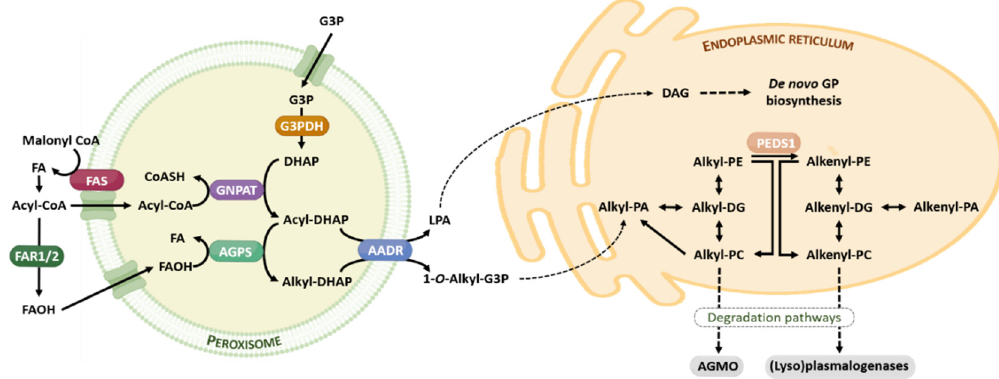
Figure 2. Ether lipid metabolism. The ether lipid biosynthesis process initiates in peroxisomes and is subsequently completed in the endoplasmic reticulum. Briefly, the early steps of ether lipid biosynthesis in the peroxisomes are based on substrates derived from fatty acid metabolism (AcylCoA) and glycolysis (DHAP), and the rate-limiting step is the provision of FAOH. The completion of GP biosynthesis occurs in the endoplasmic reticulum using DAG and Alkyl-PA as precursor molecules. The catabolism of ether lipids proceeds by their lyso-forms for alkyl lipids, and is catalyzed by AGMO, and by (lyso)plasmalogenases in the case of alkenyl lipids. Abbreviations: AAG, alkyl- acylglycerol; AGMO, alkylglycerol monooxygenase; AGPS, alkylglycerone phosphate synthase; DAG, diacylglycerol; DHAP, dihydroxyacetone phosphate; FAOH, fatty alcohol, FAR 1 and FAR2, fatty acyl-CoA reductase; FAS, fatty acid synthase; G3P, glycerol 3-phosphate; G3PDH, glycerol 3- phosphate dehydrogenase; GNPAT, glyceronephosphate O-acyltransferase; GP, glycerophospholipid; LPA, lysophosphatidic acid; PEDS1, plasmanylethanolamine desaturase. For additional details see references